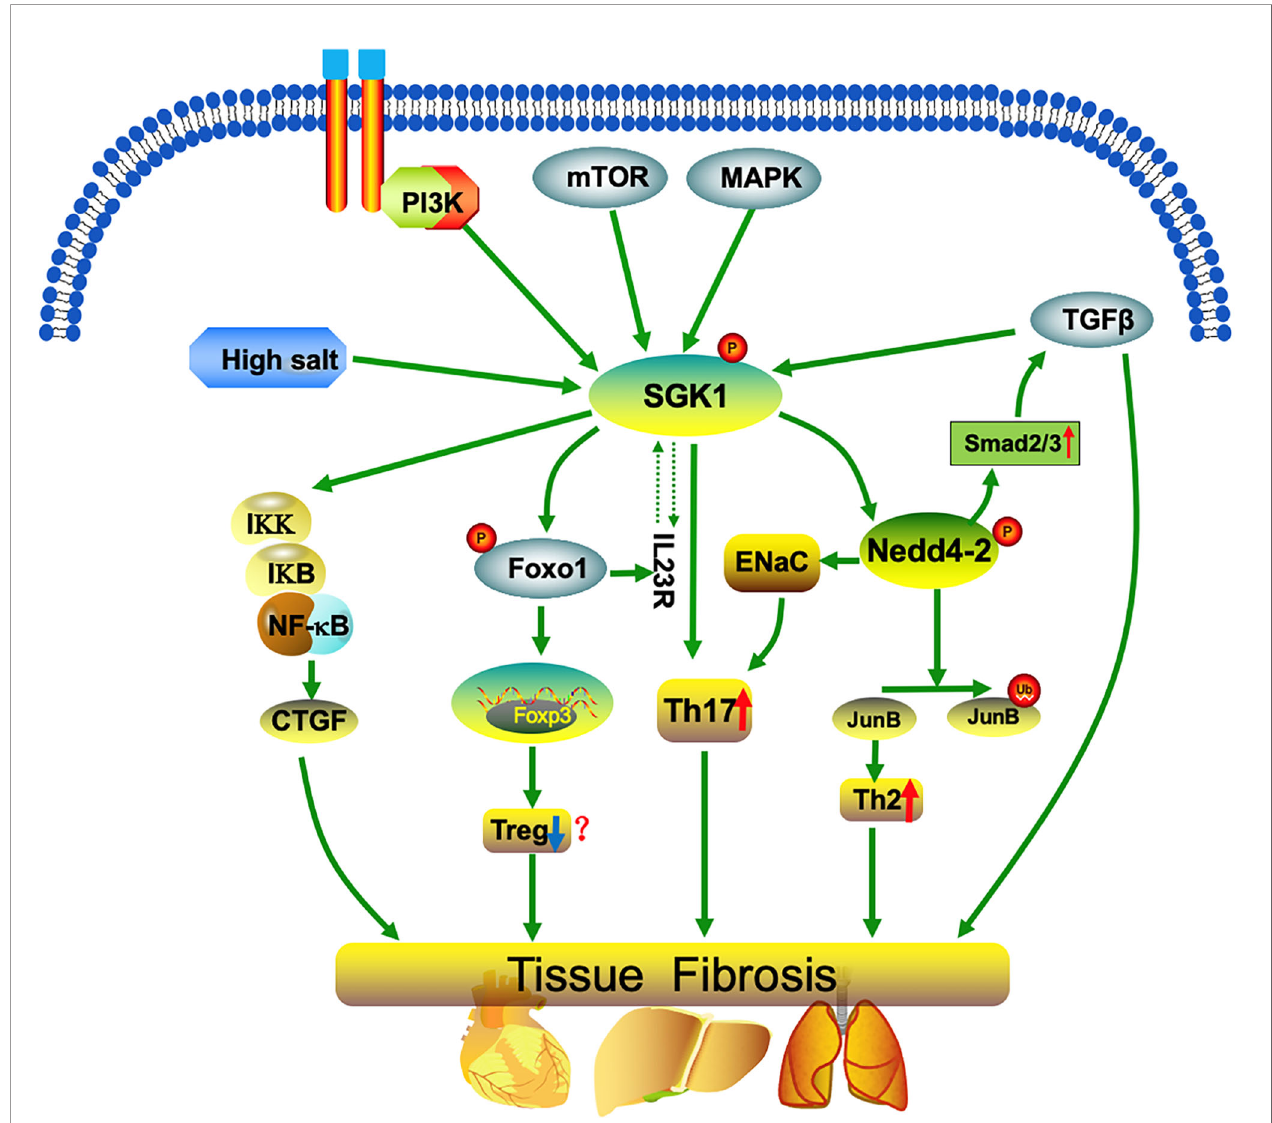
FIGURE 1 | SGK1 mediates imbalanced differentiation of Th17 and Th2 cells. SGK1 regulation occurs both at the level of transcription (for example, by a high-salt diet, p38MAPK, or TGF- b ) and at the post-translational level. SGK1 phosphorylates the ubiquitin ligase, NEDD4, and induces Th cell differentiation into Th17 and Th2 phenotypes, hinders Treg development (promotes Treg differentiation in a few studies), and promotes up-regulation of the transcription factor, SMAD2/3, thereby amplifying the pro- fi brotic effects of TGF- b . Further, SGK1 up-regulates the in fl ammatory transcription factor, nuclear factor- k B (NF- k B), which in turn stimulates the expression of multiple in fl ammatory mediators, including connective tissue growth factor (CTGF). Together, the processes described above promote the occurrence of in fl ammation and fi